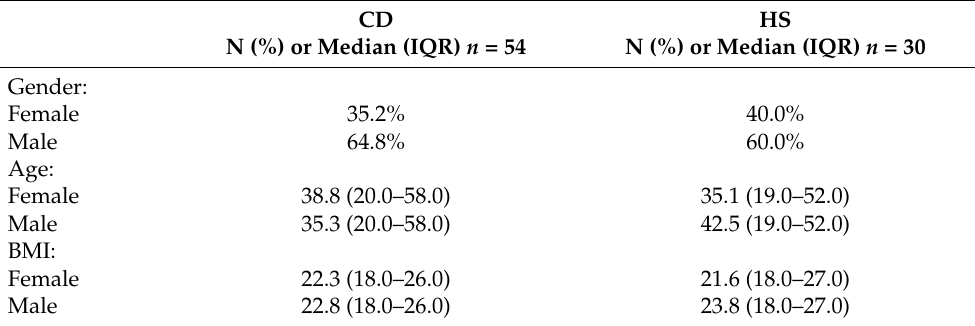
Table 4. Demographics in study cohorts of Crohn’s disease (CD) and healthy subjects (HS).